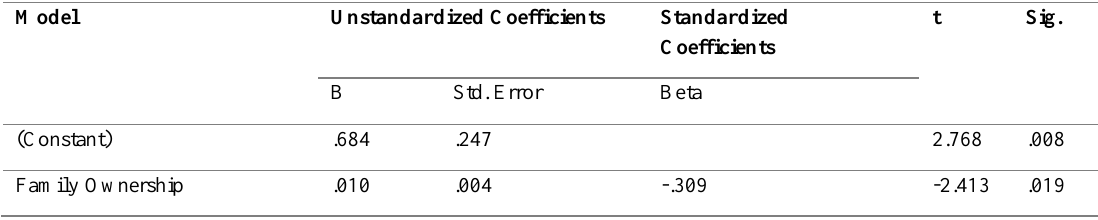
Table 6: Hypothesis 1 Testing Result